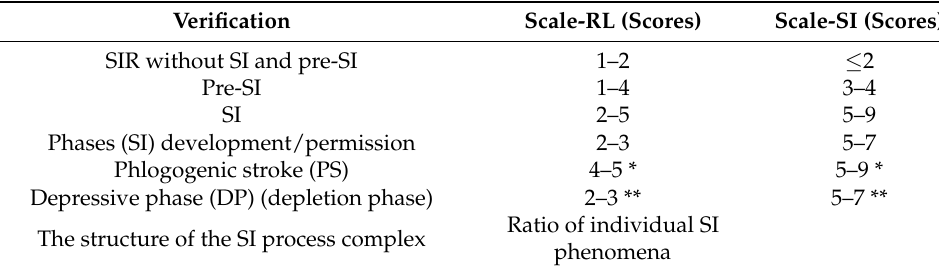
Table 6. Verification of SI phases using SI and RL integral